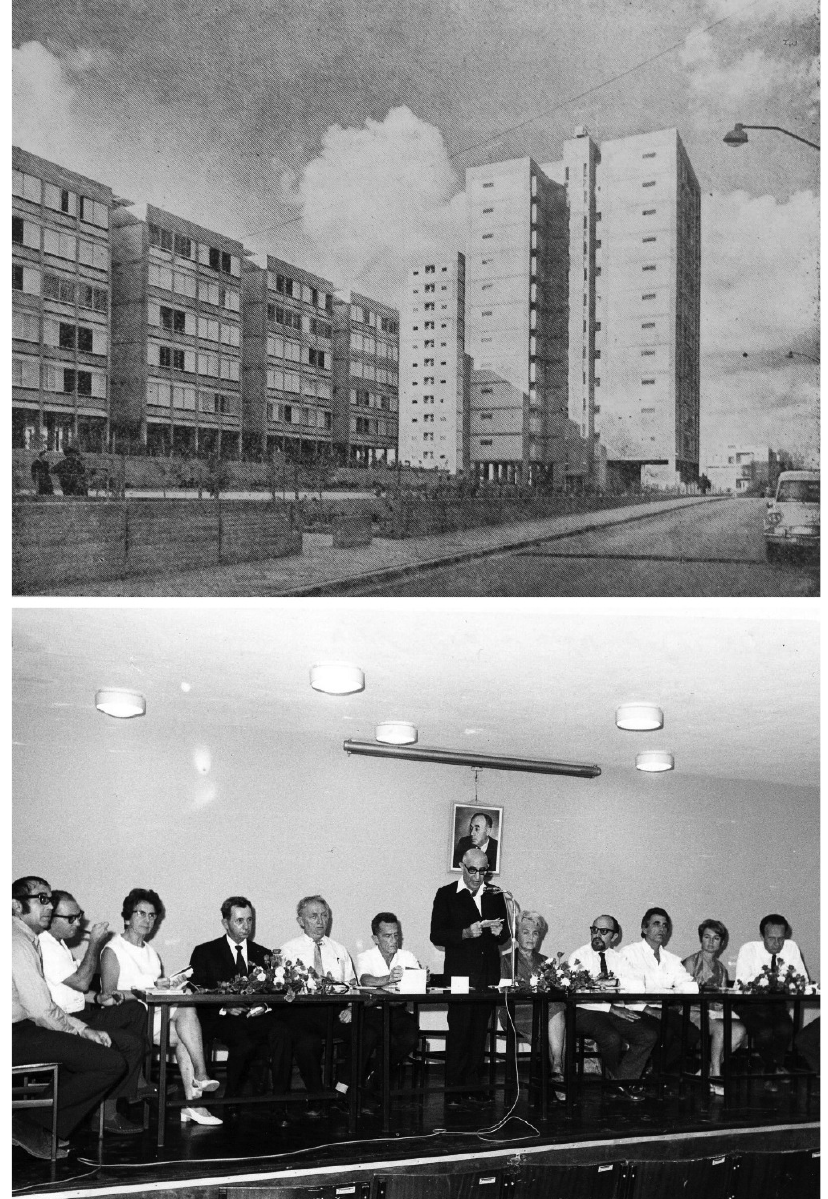
Figure 1. Top: Be’eri estate, 1970. Bottom: Be’eri estate team receiving the City of Tel Aviv Rokach Award for architecture for the estate’s design (1970, September 13). Standing at the center, Mayor Yehoshua Rabinowitz. The second figure to the left and further left: Arieh Sharon, Benjamin Idelson, Chaya Karmi (widow of Dov Karmi who passed away in 1962), Zvi Meltzer, and Ram Karmi. Source: “Rokach Award”